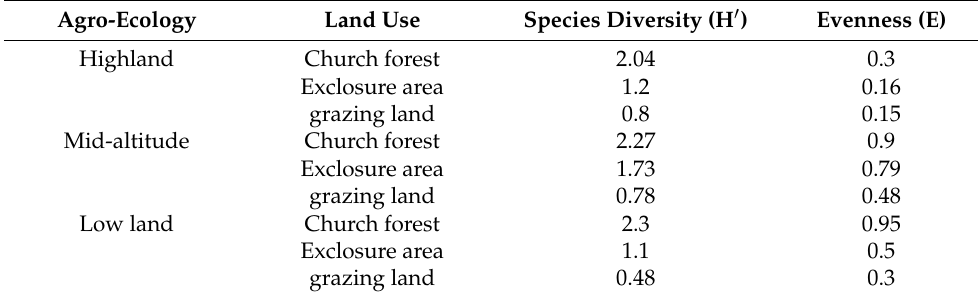
Table 2. Species diversity and evenness in different land use and agro-ecology. Agro-Ecology Land Use Species Diversity (H (cid:48) ) Evenness (E) Highland Church forest 2.04 0.3 Exclosure area 1.2 0.16 grazing land 0.8 0.15 Mid-altitude Church forest 2.27 0.9 Exclosure area 1.73 grazing land 0.78 Low land Church forest grazing